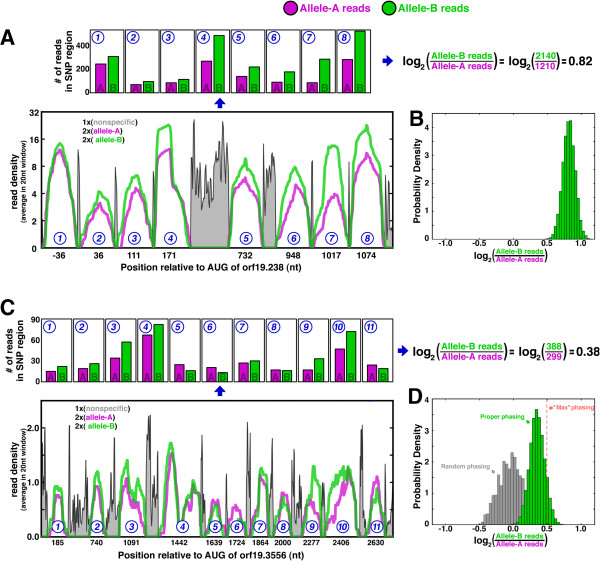
Allele-specific bias in transcription is evident from pooling reads across phased SNPs. (A, C) orf19.238 (A) and orf19.3556 (C) have 8 and 11 non-overlapping regions, respectively, where RNA-seq reads include SNPs and can be attributed to either allele A in purple, or allele B in green. The bar graphs at top quantify the number of reads per SNP region, with the line graph at bottom indicating read density in a 20 nucleotide sliding window across each region. The density of reads lacking SNP information is indicated in gray. For visual clarity, the x-axis is nonlinear, such that SNP regions show data at every nucleotide, and non-SNP regions show data every 10 nucleotides. (B, D) Allele-specific biases for orf19.238 (B) and orf19.3556 (D), where histograms reflect the results from 10,000 bootstrap iterations. (D) The gray histogram shows how randomly permuting the phasing masks allele-specific bias, and the ‘max phasing’ line indicates the bias calculated if the maximum and minimum values for each bar in the top of (C) were attributed to allele B and allele A, respectively.